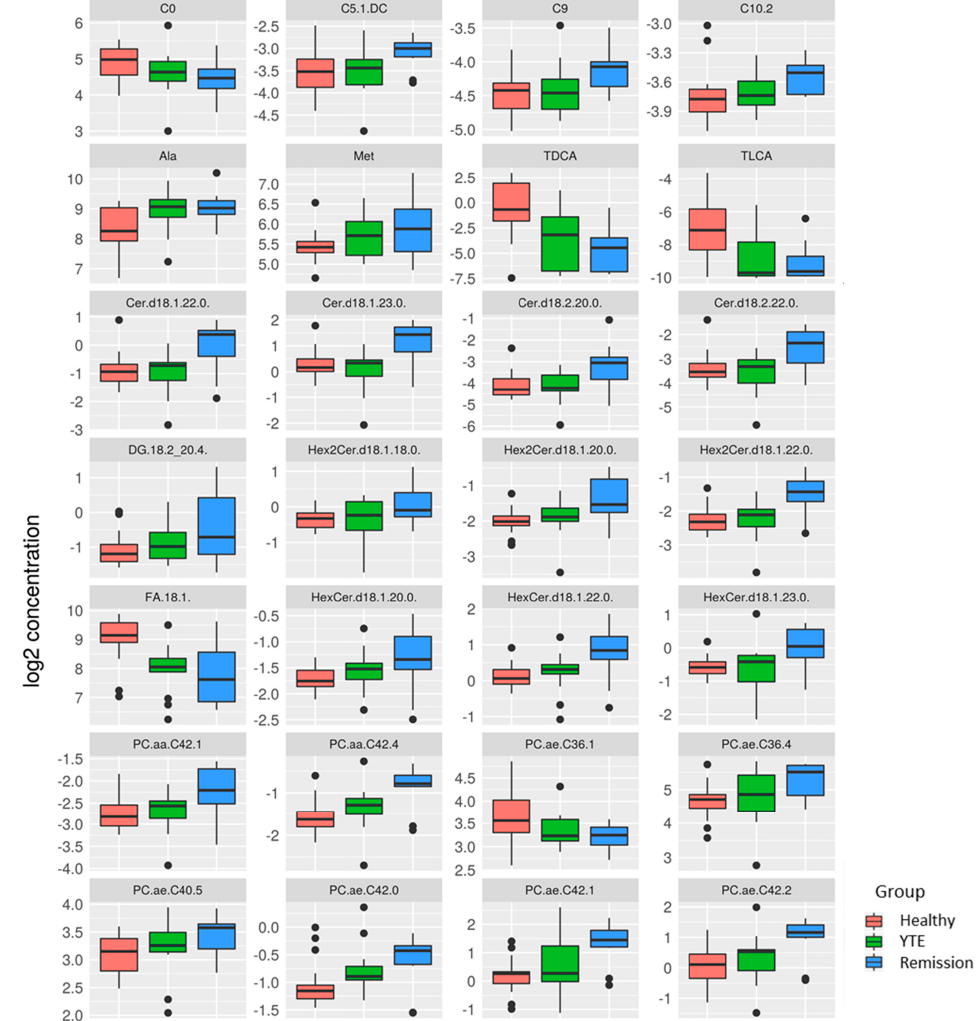
Figure 4. Box plots comparing metabolites after log-2 transformation in healthy controls, dogs with YTE, and dogs with YTE in clinical remission. Box plots of metabolites with significant differences between healthy dogs and YTE dogs in remission are shown. Box plots represent the 25–75th per- centile; the median is shown as the heavy dark horizontal line. Vertical lines extend to the minimum and maximum values. Dots represent outliers. Legend: C, carnitine; Ala, alanine; Met, methionine; TDCA, taurodeoxycholic acid; TLCA, taurolithocholic acid; Cer.d, ceramide; DG, diaglyceride; Hex2Cer.d, dihexosylceramide; FA, fatty acid; HexCer.d, hexosylceramide; PC, phosphatidylcho- line.